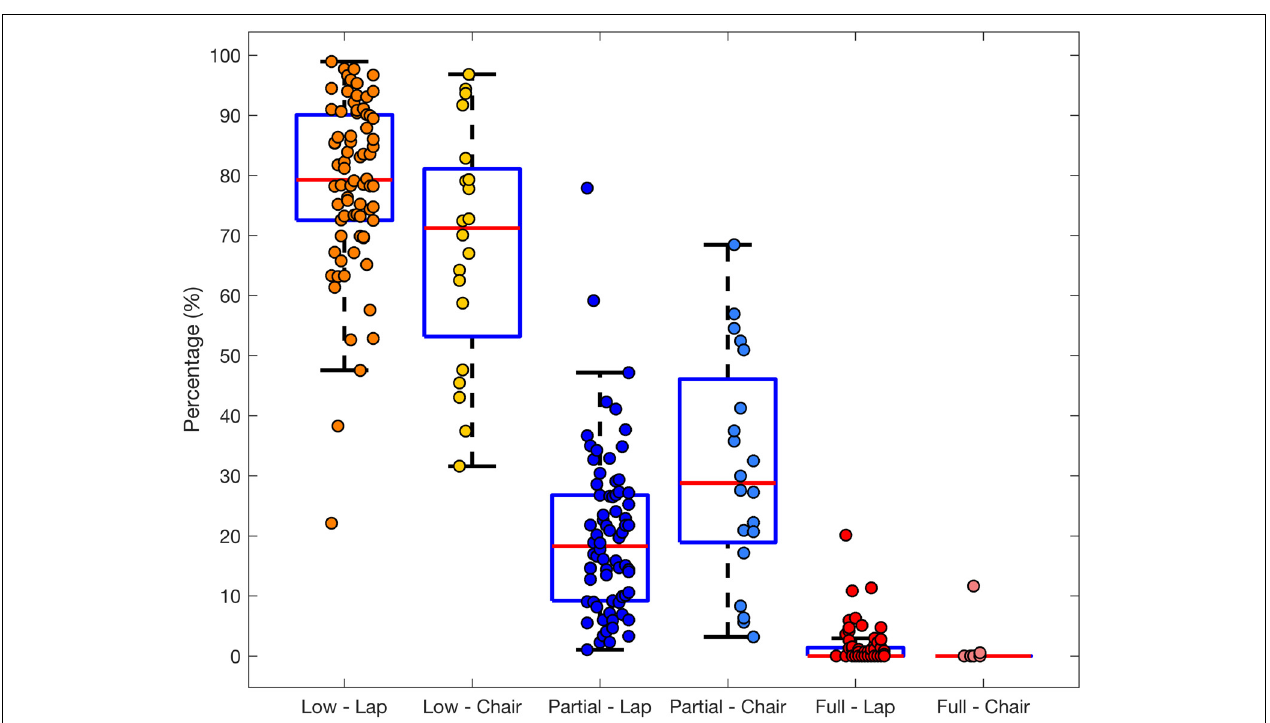
FIGURE 1 | Boxplot with overlaid dots (individual participants) representing the total duration (proportion of observation time) of low, partial and full movement for infants seated on a lap ( n = 74) or a chair ( n =